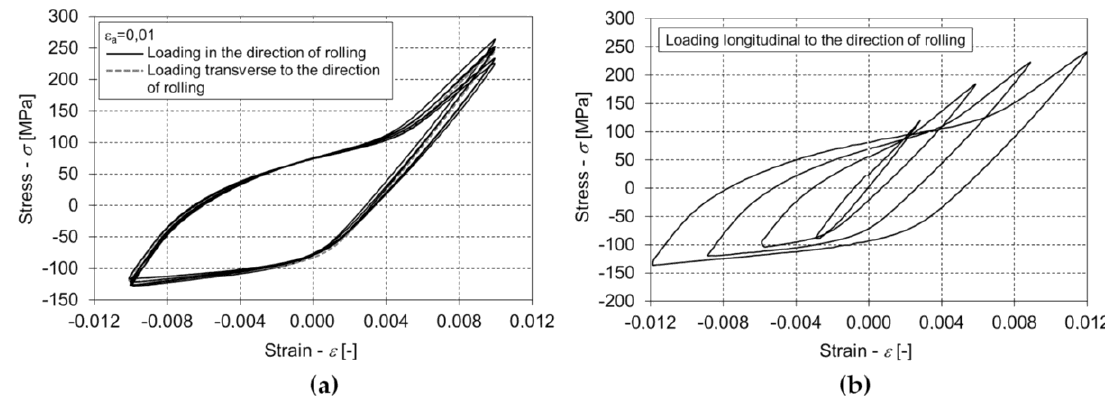
Figure 9. Closed hysteresis loops for the non-random loading: ( a ) scatter of stabilized hysteresis loops at 1% strain amplitude; ( b ) evolution of stabilized hysteresis loops for the step-test 8.